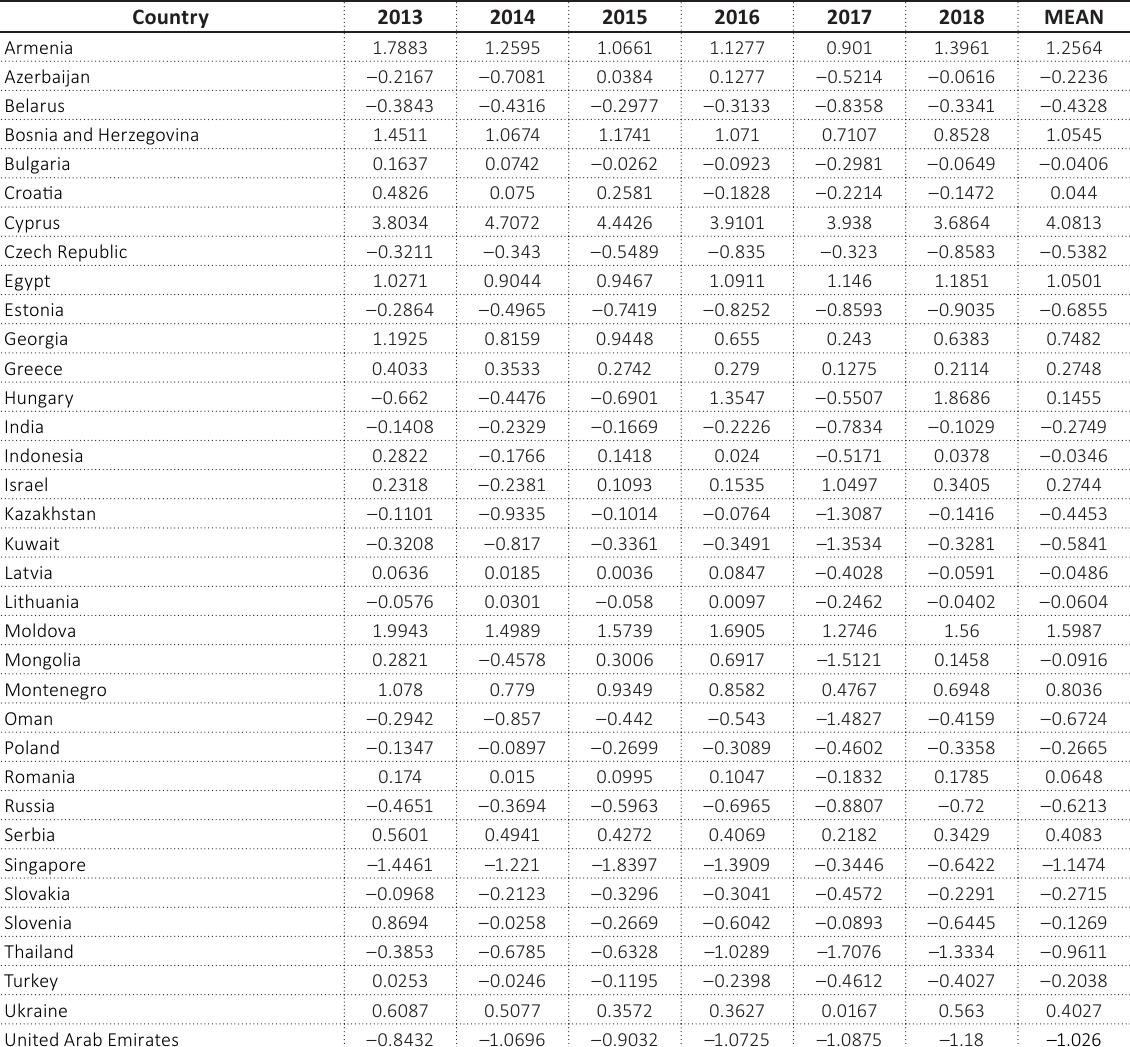
Table 2. The value of the geo-economic relationship between China and the BRI countries from